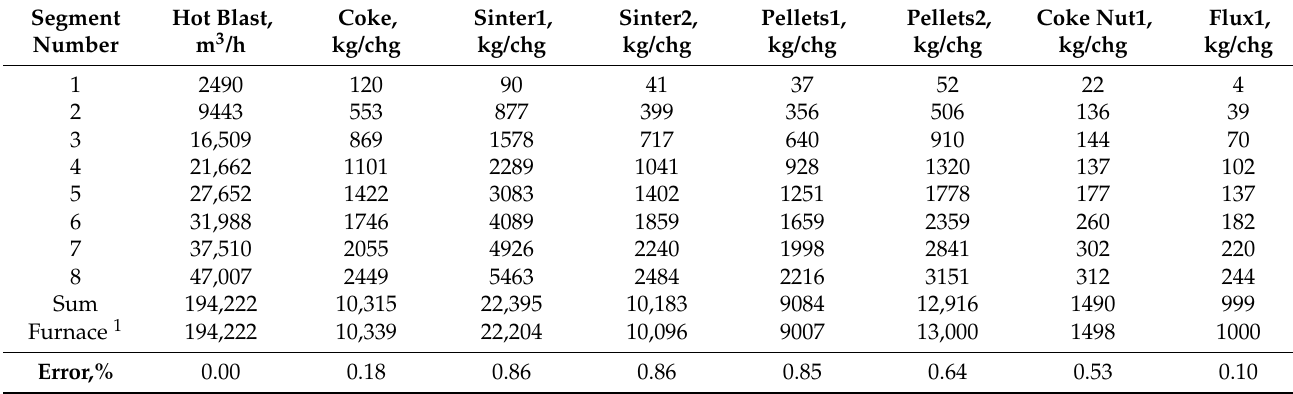
Table 2. Hot blast and charge material segmental distribution.